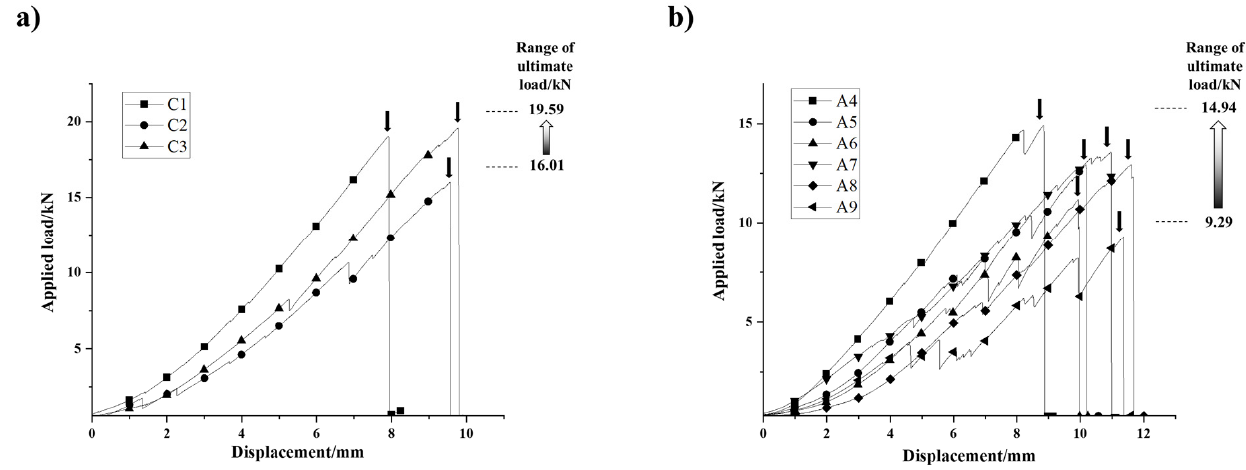
Figure 9. ( a ) Loading curves of three BFRP tendon specimens of batch C; ( b ) loading curves of six BFRP tendon specimens of batch A.